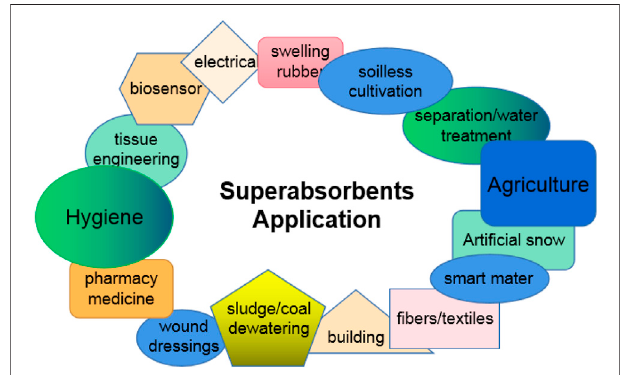
FIGURE 1 | Applications of superabsorbent polymers.